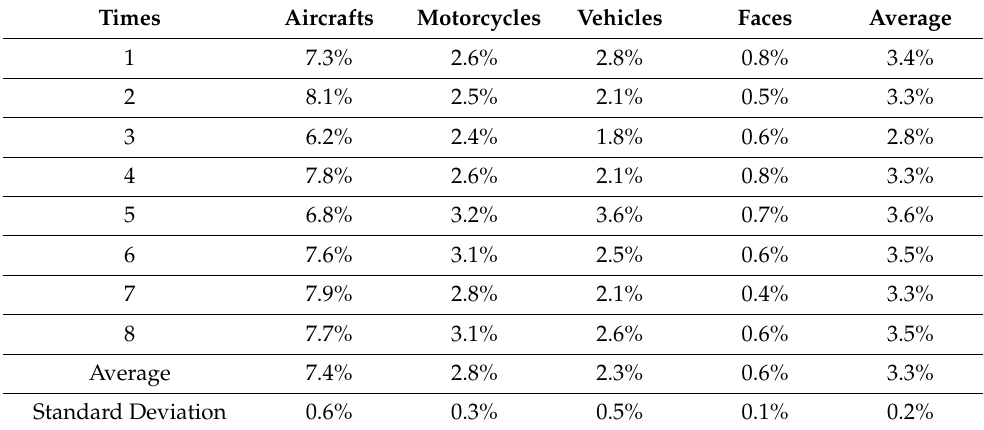
Table 5. Caltech experimental results (error rate).